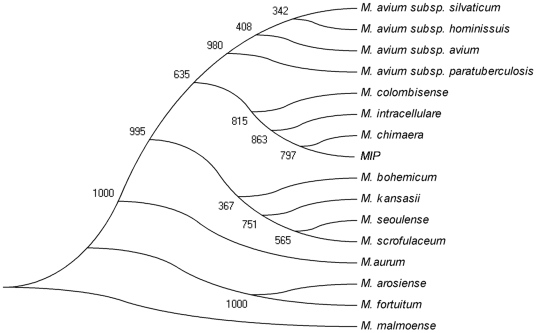
Phylogenetic positioning of MIP:The Phylogenetic positioning of MIP with respect to other members of genus Mycobacterium was performed by making concatenated tree of 16S rRNA, rpoB and hsp65 involving members of MAC and other environmental isolates, which are close to MIP. The alignment was carried out using clustal x ver 1.81[50] and a phylogenetic tree rooted to M. malmoense was constructed using Neighbor joining (NJ) method with 1,000 bootstrap iterations [51].